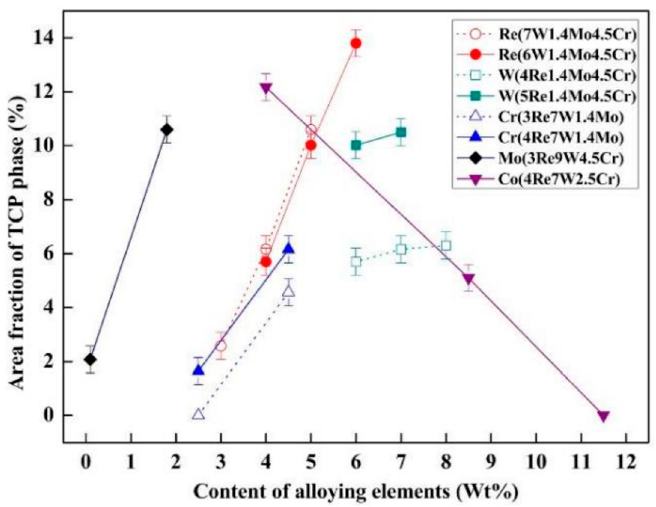
Figure 15. Area fraction of TCP phases of alloys with different alloying elements contents after ther- mal exposure at 1000 °C for 1000 h [60]. thermal exposure at 1000 ◦ C for 1000 h